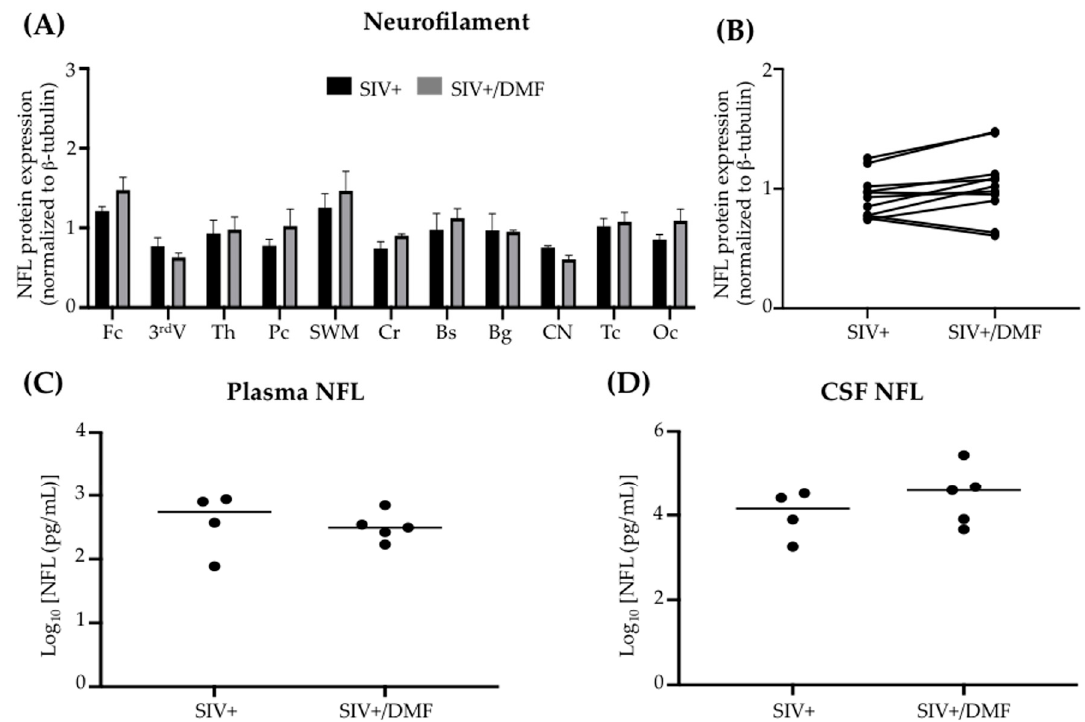
Figure 11. DMF treatment was not associated with changes in NFL. ( A , B ) NFL in the brain tissue, as determined using Western blot. Eleven brain regions from 9 SIV-infected rhesus macaques (4 untreated animals and 5 DMF-treated (90 mg total DMF daily)) were analyzed. In panel ( B ), each dot represents the mean average for each region and group. ( C ) The plasma and ( D ) cerebrospinal fluid (CSF) NFL did not change with the DMF treatment. NFL was quantified using a Singleplex Assay (Meso Scale Discovery, Rockville, MD, USA). Each dot represents the NFL value for each animal. Fc: frontal cortex, 3 rd V: third ventricle, Th: thalamus, Pc: parietal cortex, SWM: subcortical white matter, Cr: cerebellum, Bs: brainstem, Bg: basal ganglia, CN: caudate nuclei, Tc: temporal cortex, Oc: occipital cortex. All values are expressed as mean ± SEM.